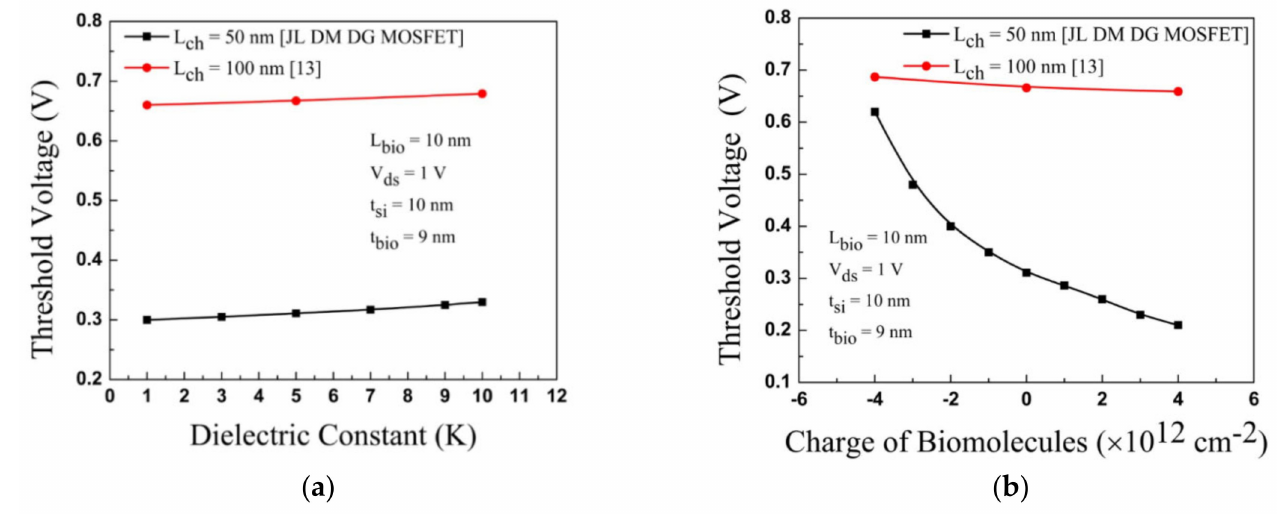
Figure 9. Variation of threshold voltage for JL-DM-DG-MOSFET and [13]: ( a ) neutral biomolecules; ( b ) charged biomolecules.